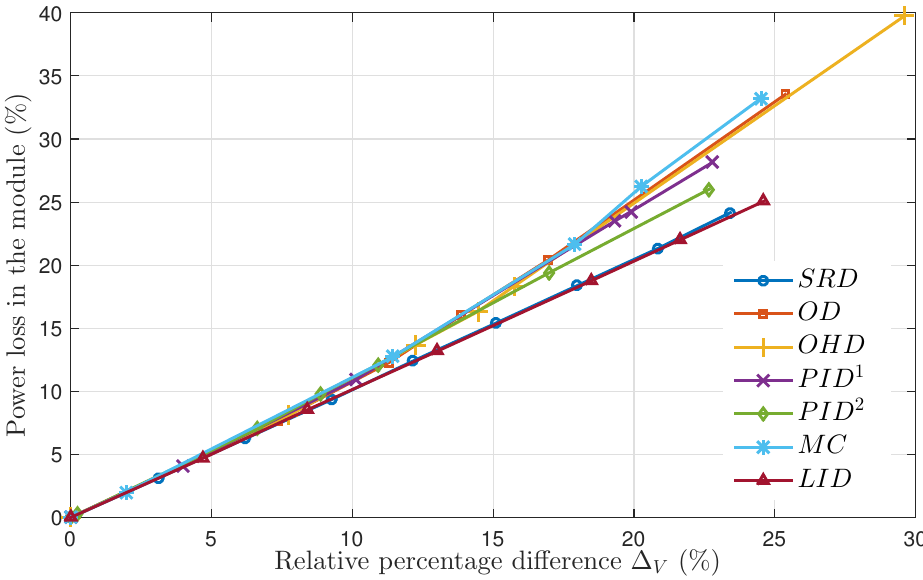
Figure 4. Power loss of the modules versus ∆ V at mpp for the studied